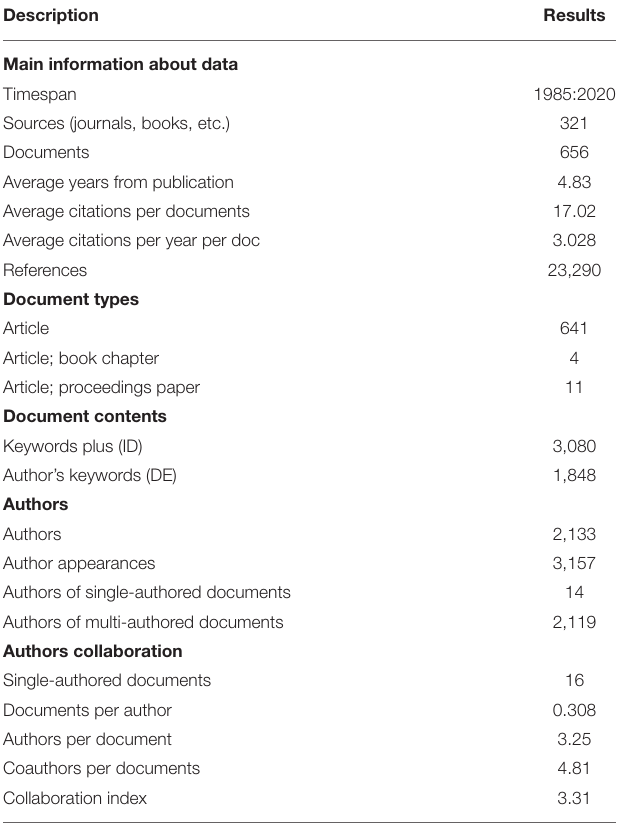
TABLE 1 | General information on the retrieved published documents on meat production and nanotechnology from WOS and Scopus data